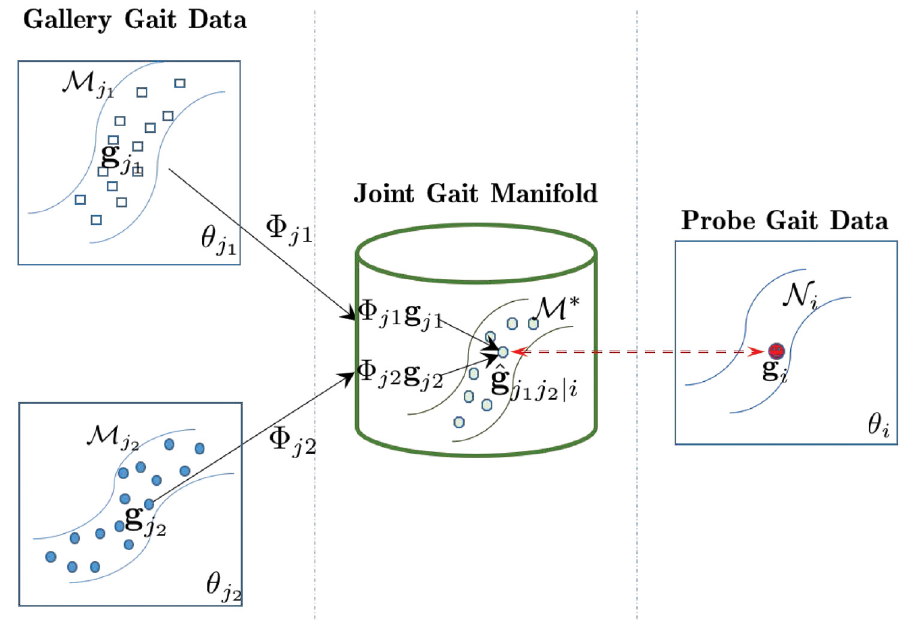
Fig 7. Illustration of joint gait